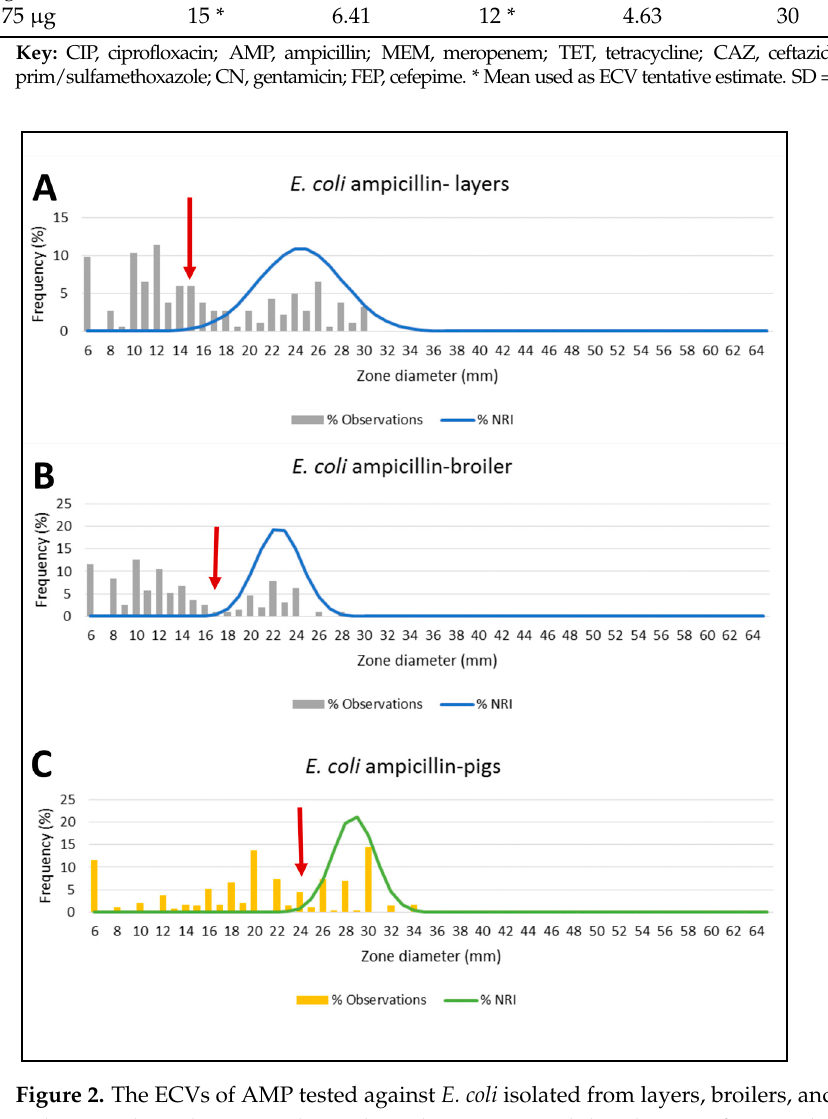
Table 4. ECVs of tested antibiotics against E. coli .